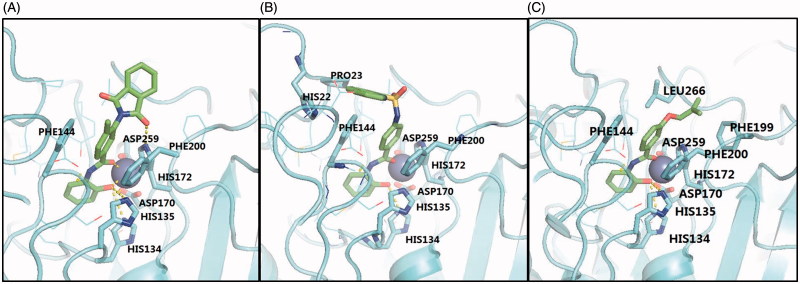
The modes of compound 2 (A), 2–1 (B) and 2–2 (C) bound to HDAC3, predicted by FRED. Colour codes: light blue, HDAC3; green, hit compounds; blue sphere, zinc ion.